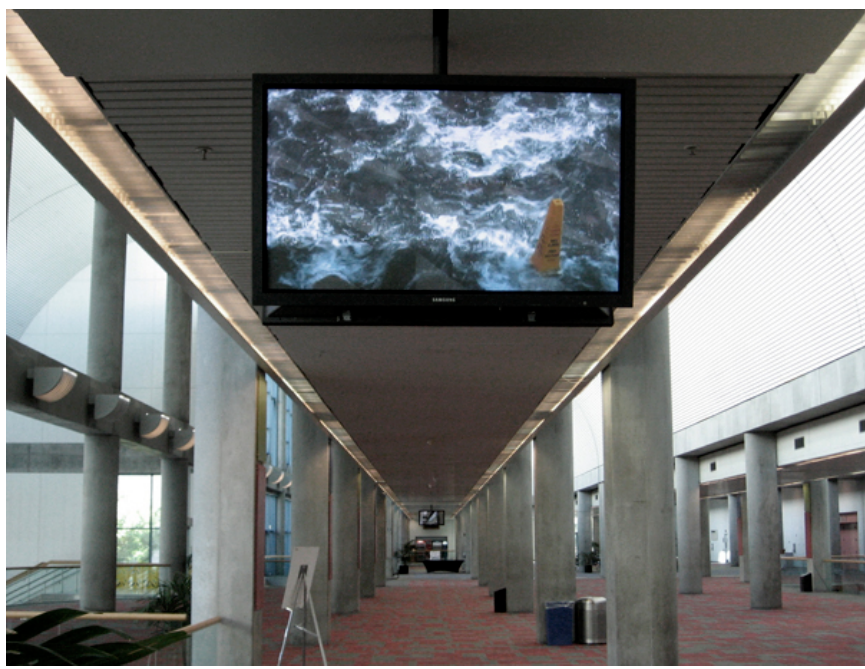
Figure 2: Animated image from Zurkow’s Paradoxical Sleep (2008), displayed on video screens in the San Jose McEnery Convention Center and suggesting that the Guadalupe River is overflowing into the space. Image courtesy of the artist and bitforms